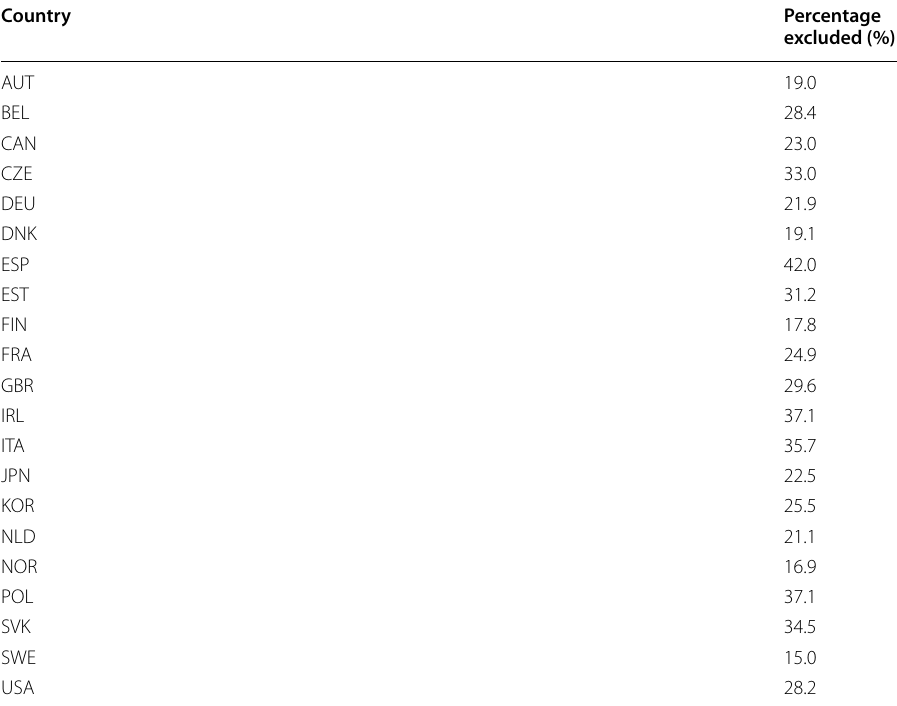
Table 5 Percentage of missing/not inferred/not stated earning information by country